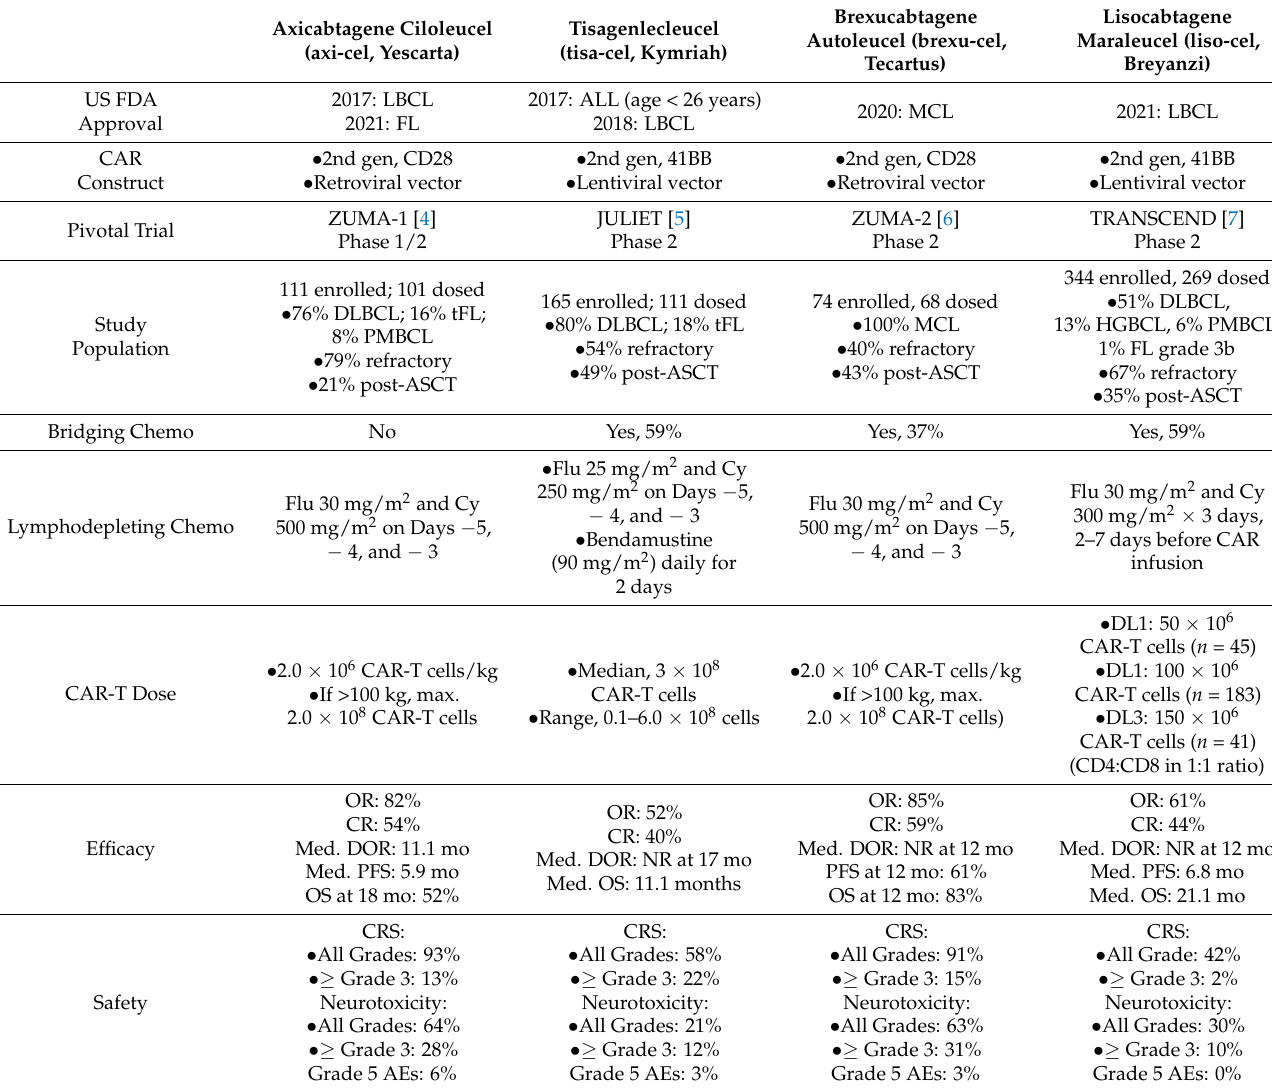
Table 1. Summary table of the 4 FDA-approved CD19 CAR-T products for B-cell lymphomas and the results of their pivotal trials. Abbreviations: US: United States; FDA: Food and Drug Administration; gen: generation; DLBCL: diffuse large B-cell lymphoma; tFL: transformed follicular lymphoma; ALL: acute lymphoblastic leukemia; PMBCL: primary mediastinal B-cell lymphoma; MCL: mantle cell lymphoma; post-ASCT: post autologous stem cell transplantation; chemo: